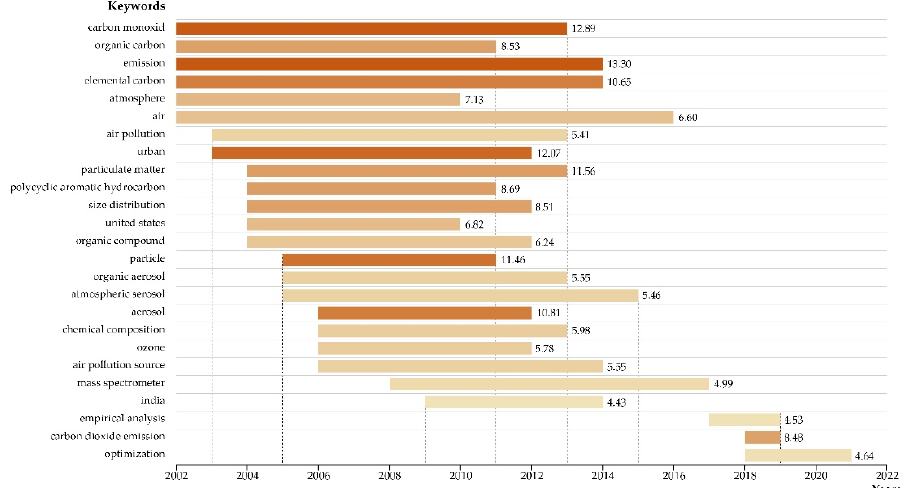
Figure 6. The top 25 keywords with the strongest citation burst words for the WOS. The data for this figure come from Citespace.